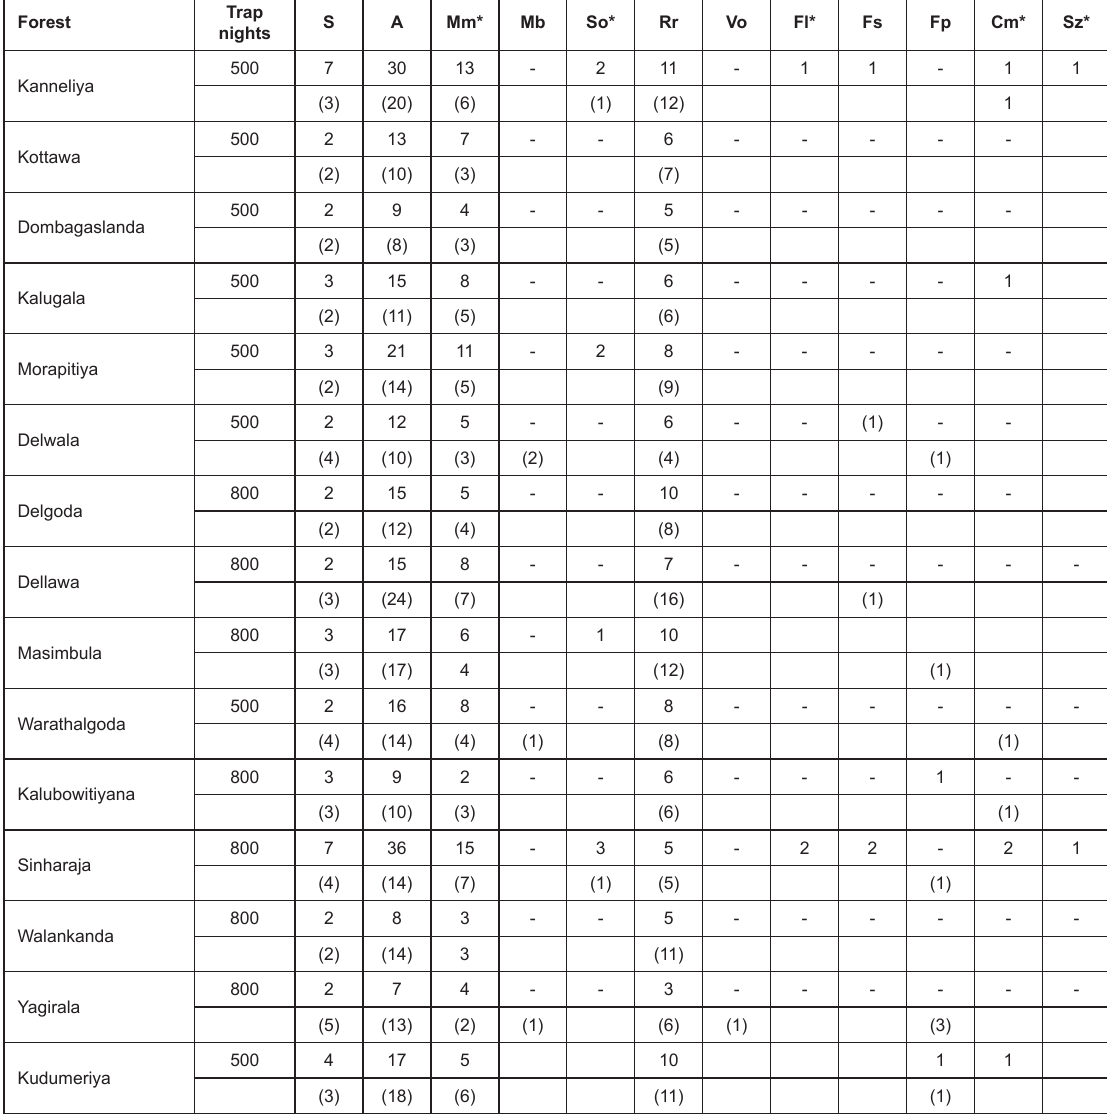
Table 2. Species richness (S) and abundance (A) of the small mammal community and of the individual species in core areas and forest edges (in parentheses) of the 15 rainforests. Trap Forest